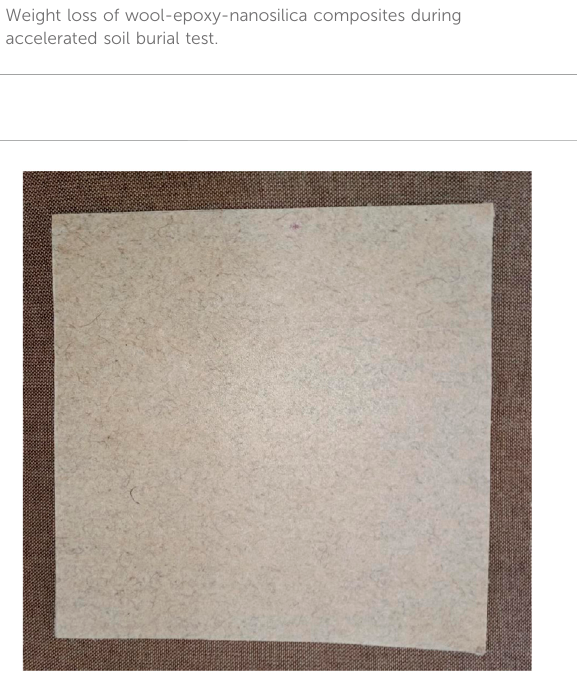
FIGURE 7 Moisture content properties of wool-epoxy-nanosilica composites.